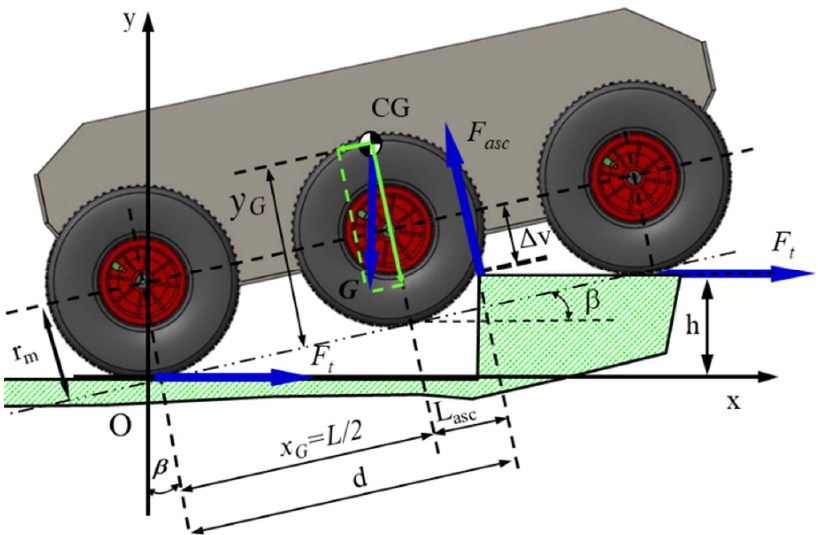
Figure 8. Schematic of the escalation of a step-type obstacle by the robot. To ensure good ability to climb the step, the front, and middle wheels to be in permanent contact with the step to be climbed. It is not mandatory to have this situation; depending on the geometry of the workspace, energy consumption can increase, which affects the autonomy of movement. The robot was designed to move without being powered by a cable.